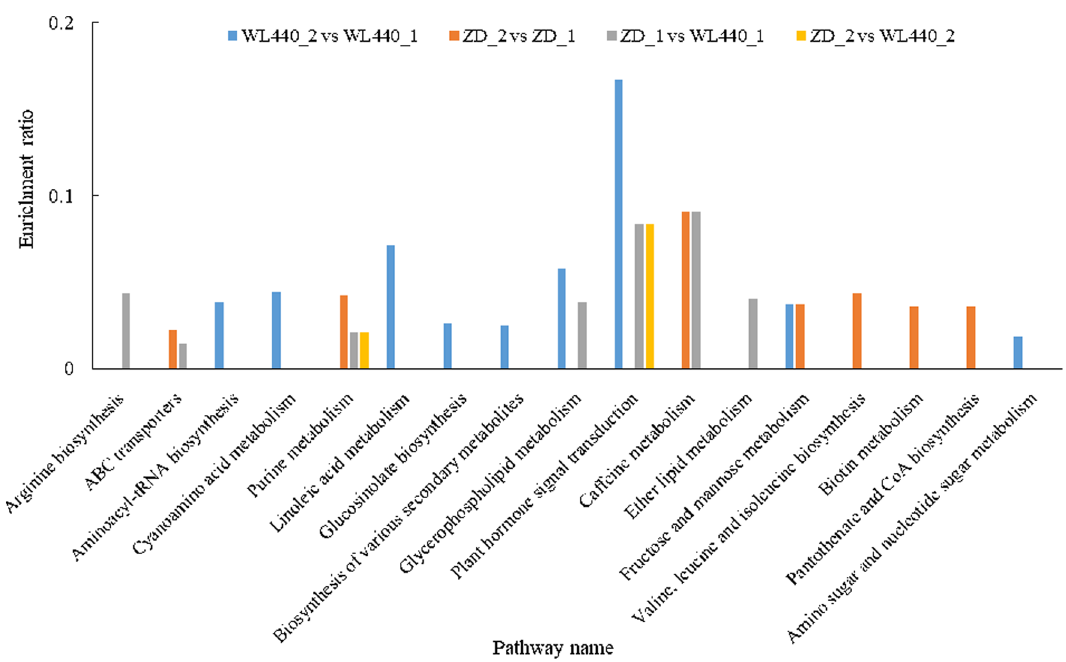
Figure 8. Enrichment ratios of 17 significantly ( P < 0.05) enriched